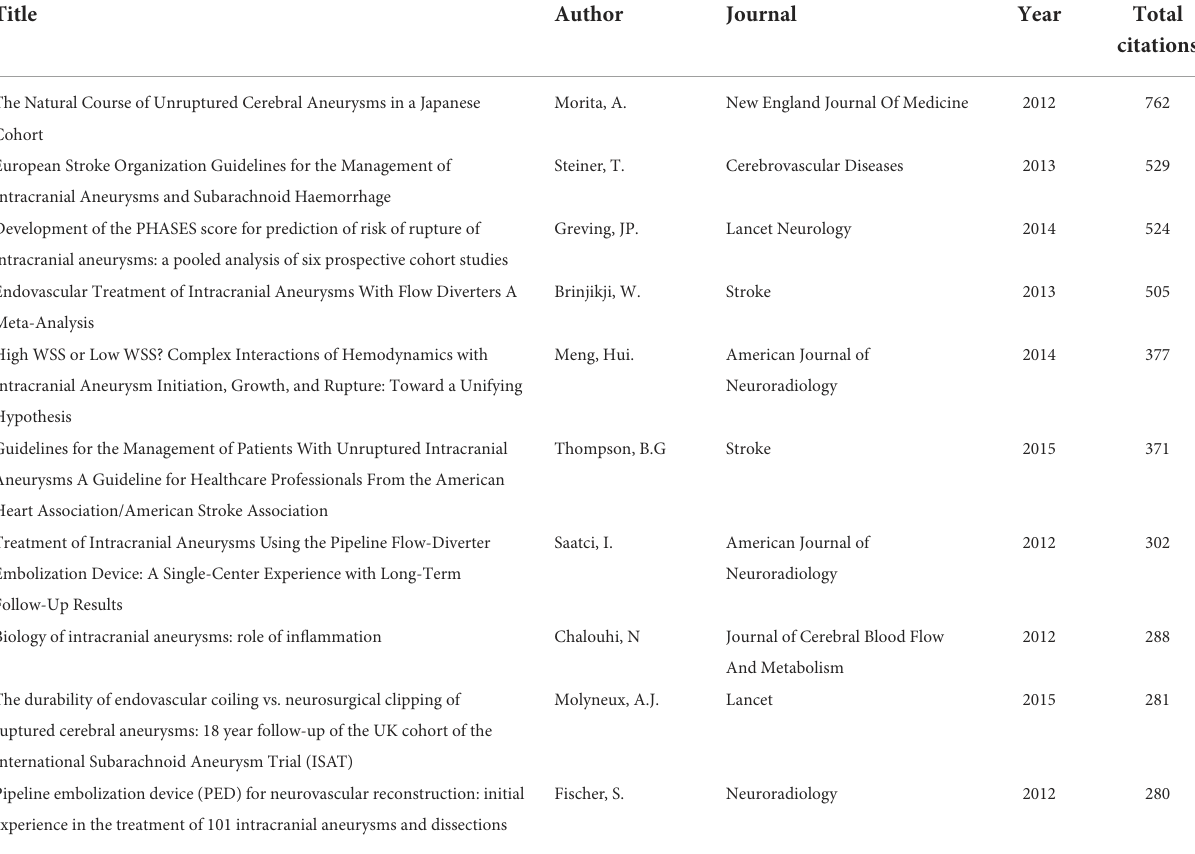
TABLE 3 The top 10 most cited publications on intracranial aneurysm research from 2012 to